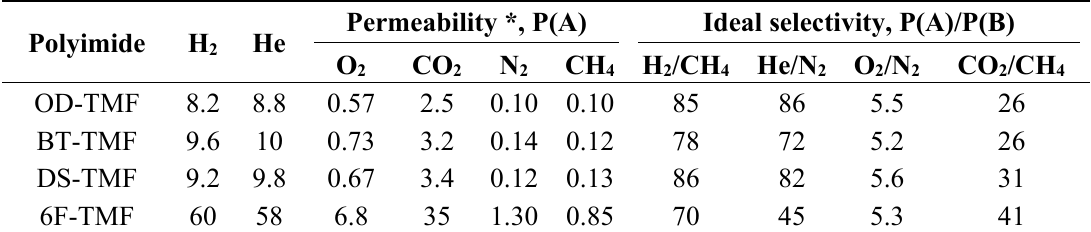
Table 3. Gas transport properties measured at 35 °C and 2 atm for the TMF-based polyimides reported in this